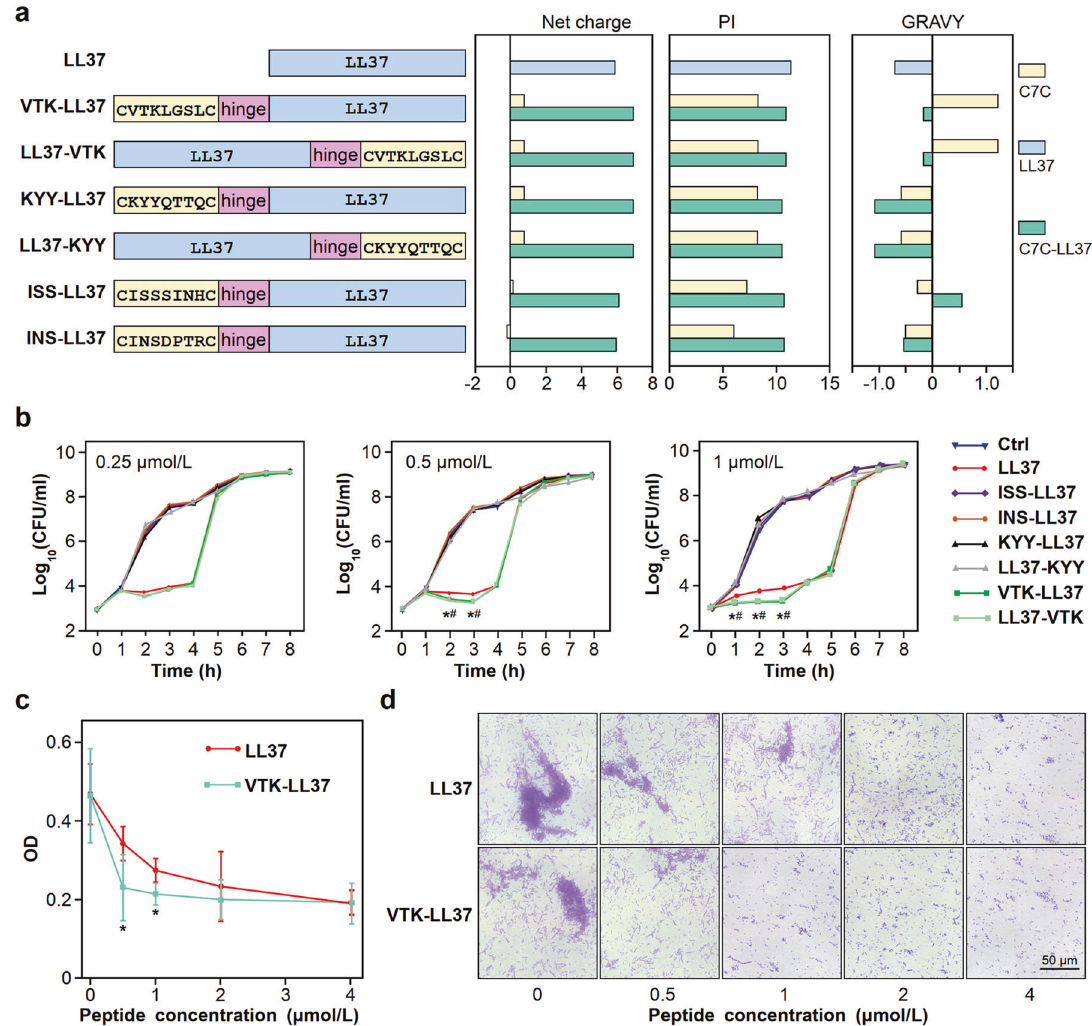
Fig. 6 Antimicrobial activity of the C7C-LL37 fusion peptides in vitro. a Primary structures and physical properties of the C7C and LL37 fusion peptides, including LL37, VTK-LL37, LL37-VTK, KYY-LL37 and LL37-KYY, ISS-LL37, INS-LL37. Net charge, PI and GRAVY values were acquired as described above. b Inhibitory effect of C7C-LL37 fusion peptides on bacterial growth. A C7C-LL37 fusion peptide or LL37 alone was added to the cultured bacterial strain MSI001 (1 × 10 3 CFU) at fi nal concentrations of 0.25 μ mol/L, 0.5 μ mol/L and 1 μ mol/L. Sterile DPBS was used as control. After incubation with the C7C-LL37 or LL37 peptides at 37 °C for different times (1-8 h), bacterial colonies were counted. n = 3. * P < 0.05, VTK-LL37 group compared to LL37 group; # P < 0.05, LL37-VTK group compared to LL37 group. c , d Inhibitory effect of VTK-LL37 on bio fi lm formation. The VTK-LL37 or LL37 peptide was added to the bacterial culture at a fi nal concentration of 0-4 μ mol/L and incubated at 37 °C for 3 days. Bacterial culture medium and the peptides were refreshed every day. The bio fi lm was stained with 1% crystal violet, and the precipitates were dissolved in 95% ethanol, followed by detection of absorbance at 570 nm (A 570 ) ( c ). Moreover, the bio fi lm was observed under a microscope ( d ). n = 5. * P < 0.05, VTK-LL37 group compared to LL37